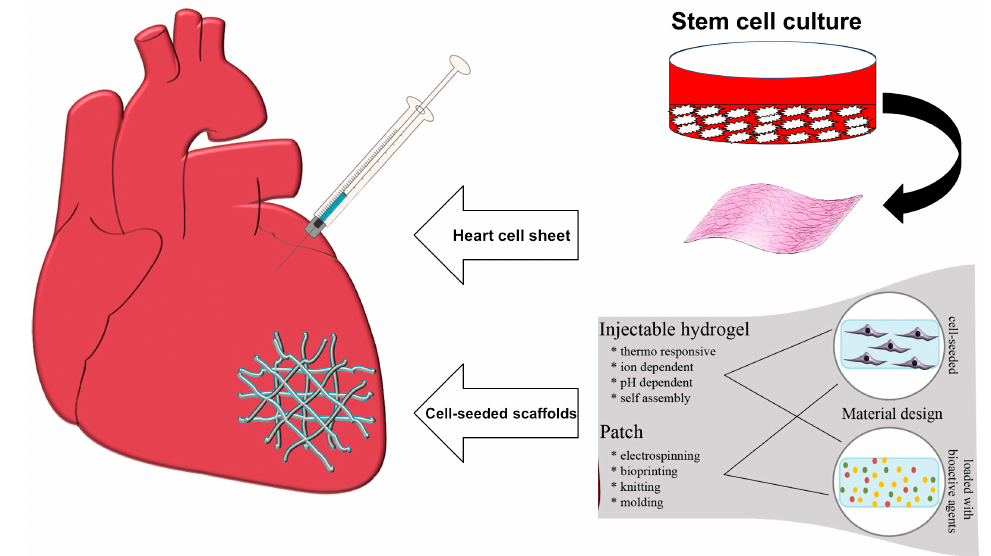
Figure 2. Examples of two approaches to cardiac tissue engineering. Stem cells are differentiated into cardiac repair cells and seeded onto a scaffold material or mixed with an injectable matrix. The scaffold with the repair cells is placed at the site of MI or used to replace the infarcted tissue. Cells encapsulated within a hydrogel matrix are delivered to the site of injury via direct injection. Images from Hinderer et al. [66] © Wiley Publishers.